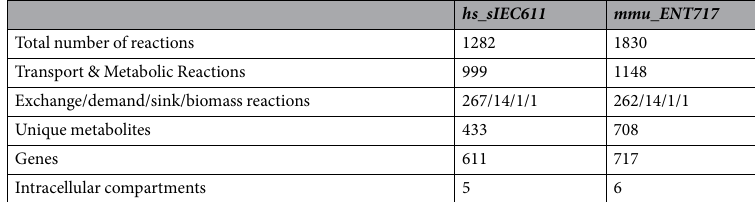
Table 1. Description and comparison of the published human small intestinal ( hs_sIEC611 ) and expanded murine-specific enterocyte ( mmu_ENT717 )